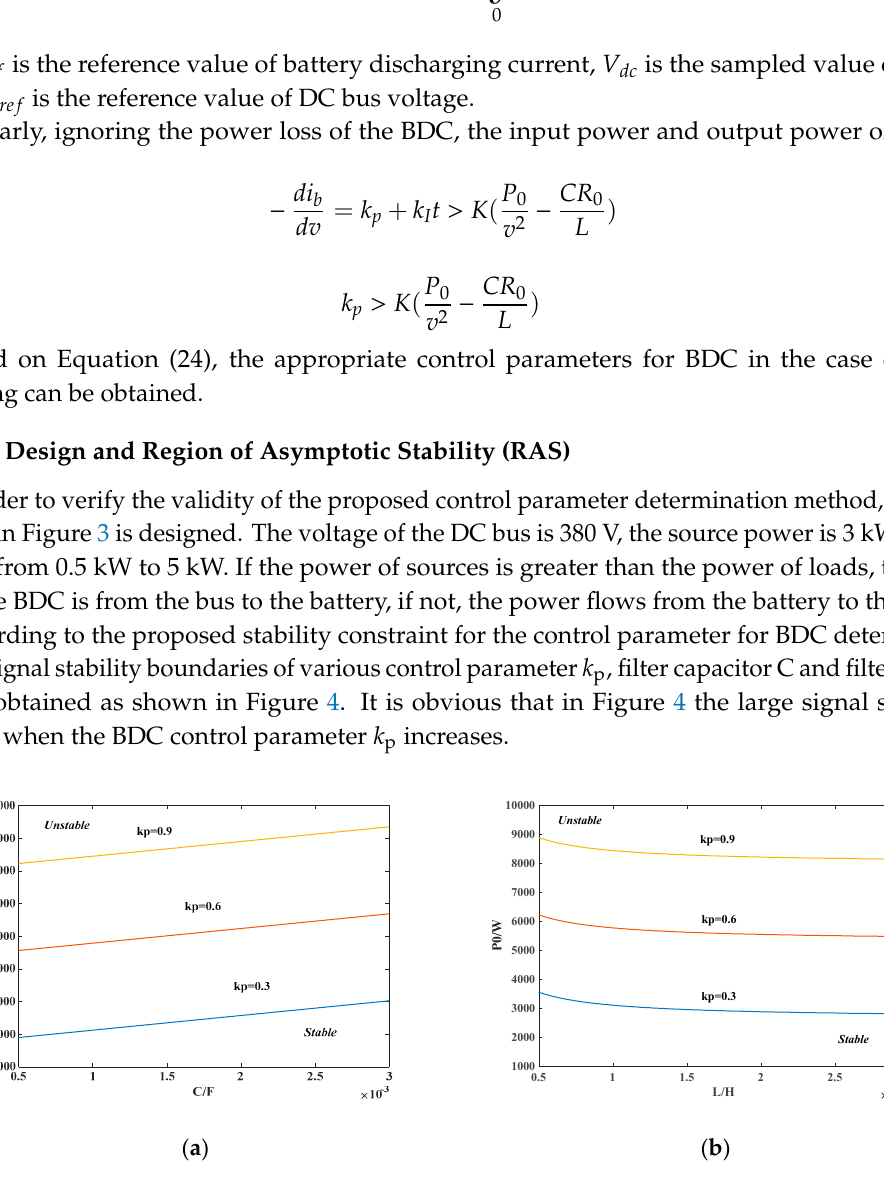
Figure 4. The large signal stability limits of system parameters: ( a ) The stable region increases with filter capacitor C and BDC control parameter k p increasing; ( b ) The stable region decreases with filter inductor L increasing and increases with the BDC control parameter k p increasing.